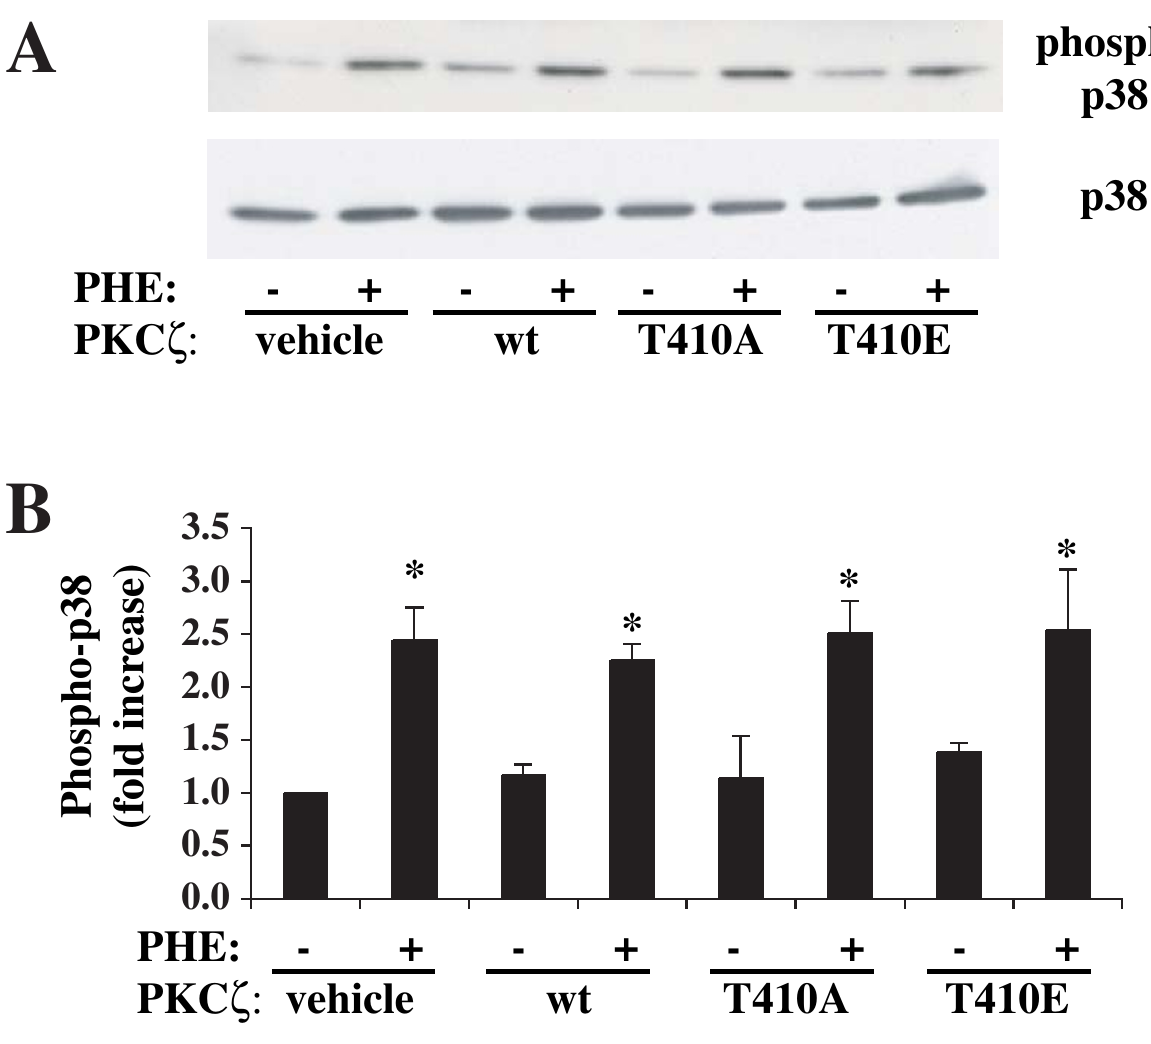
Figure 7 Effect of PKC ζ mutants on p38 phosphorylation. A, Cells were transiently transfected with wt PKC ζ , kinase-deficient T410A PKC ζ and constitutively active T410E PKC ζ for 48 h and treated with or without PHE for 5 min. Phospho-p38 and p38 protein levels in cell lysates were determined by western blot analysis as described in Methods. The bar graph (B) represents quantification of the ratio phospho-p38 / 38 protein bands by densitometric analysis of blots from four different experiments. * denotes value significantly different from vehicle (nontransfected and lipofectamine-treated cells), p <